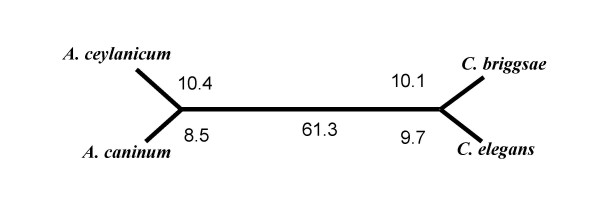
Relative distance based upon protein maximum likelihood. A. ceylanicum to A. cananum distance is similar to C. elegans to C. briggsae distance. Ancylostoma to Caenorhabditis distance for any species is 4.3X the Ancylostoma to Ancylostoma distance and 4.1X the Caenorhabditis to Caenorhabditis distance. The length of each line segment is proportional to the calculated branch length between the species.